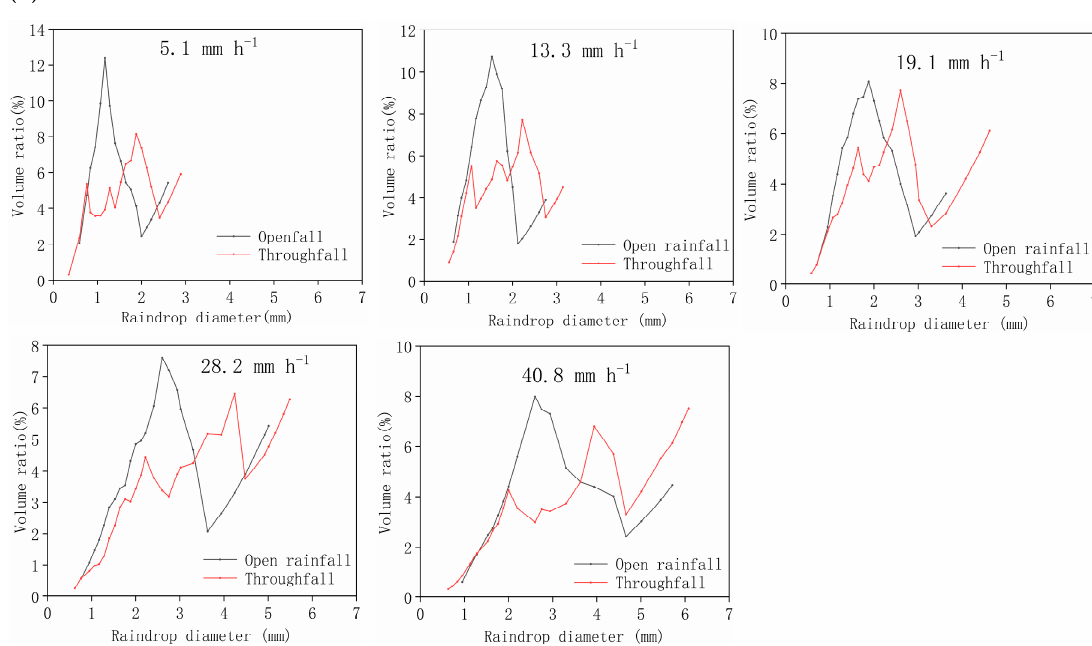
Figure 4. ( a ) Cumulative DSD for open rainfall and throughfall. The dashed, horizontal lines indicate the 50% lines of cumulative DSD. The dashed, vertical lines represent the D 50 . ( b ) DSD for open rainfall and throughfall.